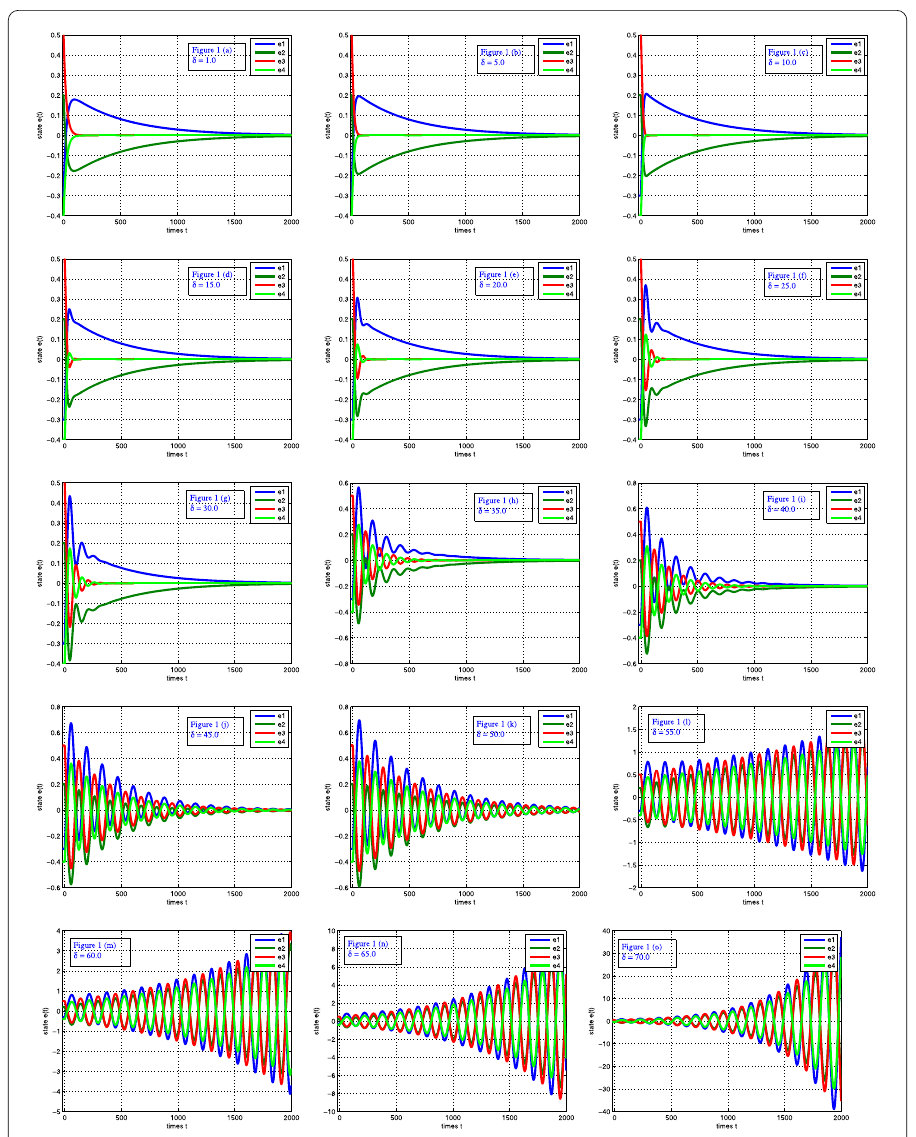
Figure 2 State responses of QTPS (61) in Example